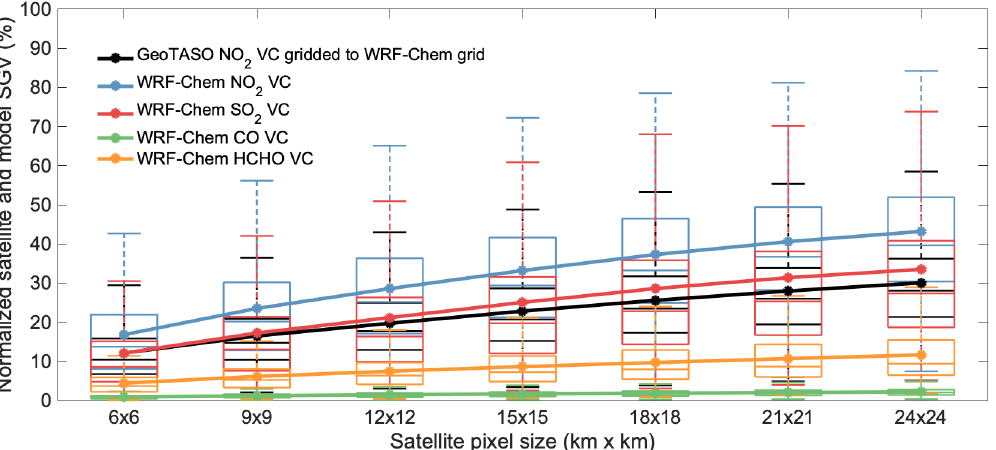
Figure 8. Boxplot of hypothetical normalized satellite SGV of NO 2 vertical column (VC), SO 2 VC, CO VC, and formaldehyde (HCHO) VC derived from the WRF-Chem simulation with a resolution of 3km × 3km (colored lines) and GeoTASO NO 2 VC that gridded to the WRF-Chem grid (black lines) over the Seoul Metropolitan Area. Medians are represented by red bars, interquartile ranges between 25th and 75th percentiles by blue boxes, and the most extreme data points not considered outliers by whiskers. The modeled NO 2 , CO, SO 2 , and HCHO are filtered to match the rasters of GeoTASO